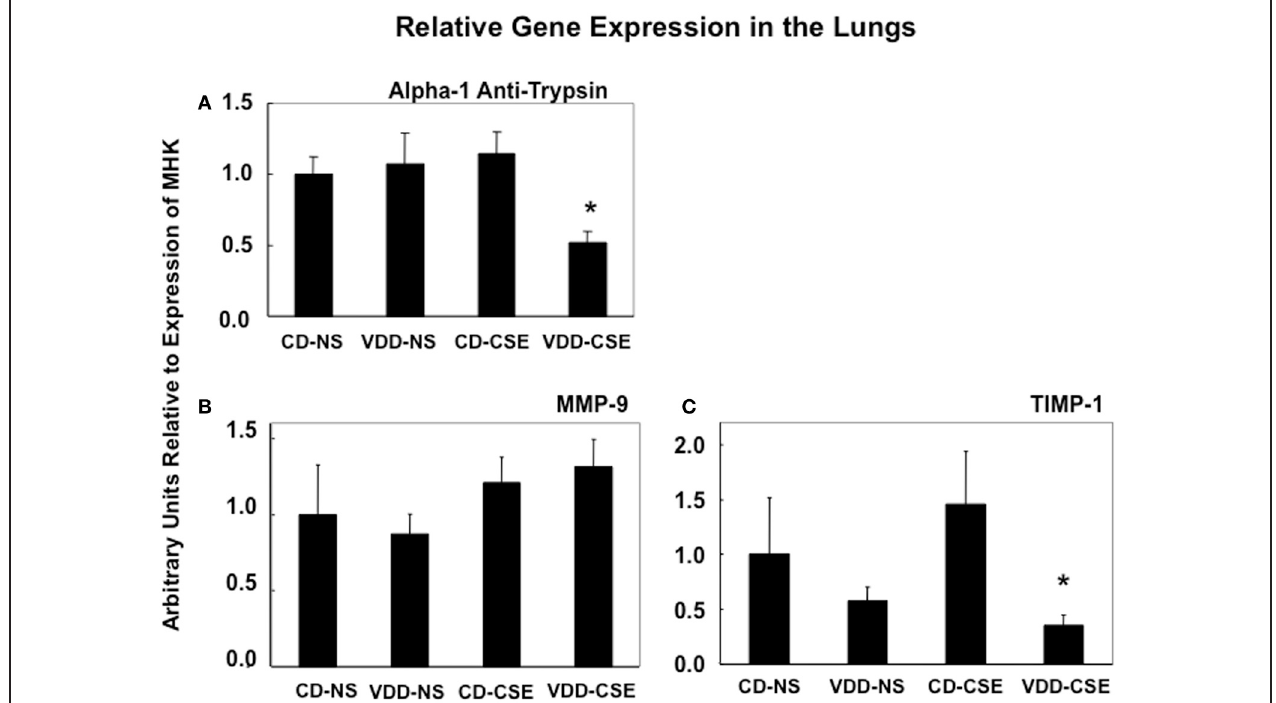
FIGURE 5 | Bars represent the ratio ± SEM of expression of genes to expression of the MHK housekeeping gene from whole lung in 4–8 mice from each treatment group. (A) Expression of A1AT is significantly different in VDD-CSE mice from control mice (CD-NS) ( p = 0 . 0060), from CSE ( p = 0 . 0019), and from VDD mice ( p = 0 . 0290).